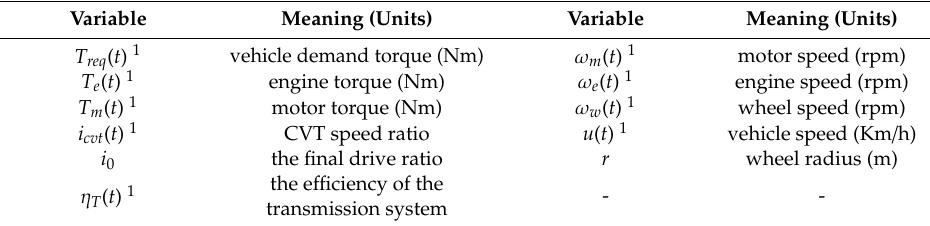
Table 2. Vehicle longitudinal dynamics model variables.